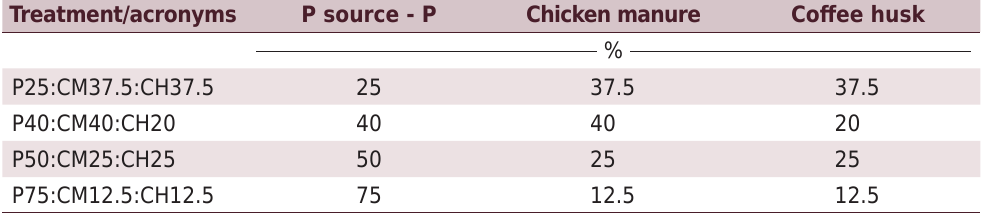
Table 2. Treatment description and their acronyms for each mixture among P sources (Araxá phosphate rock, Bayóvar phosphate rock, or monoammonium phosphate), chicken manure (CM), and coffee husk (CH), dry mass-based